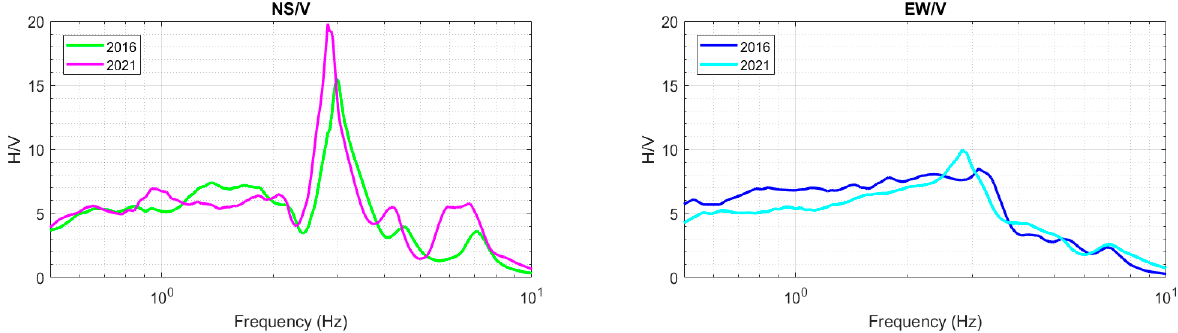
Figure 6. Comparison between ambient noise measurements carried out in 2016 and 2021 on the top of the Castle’s tower.